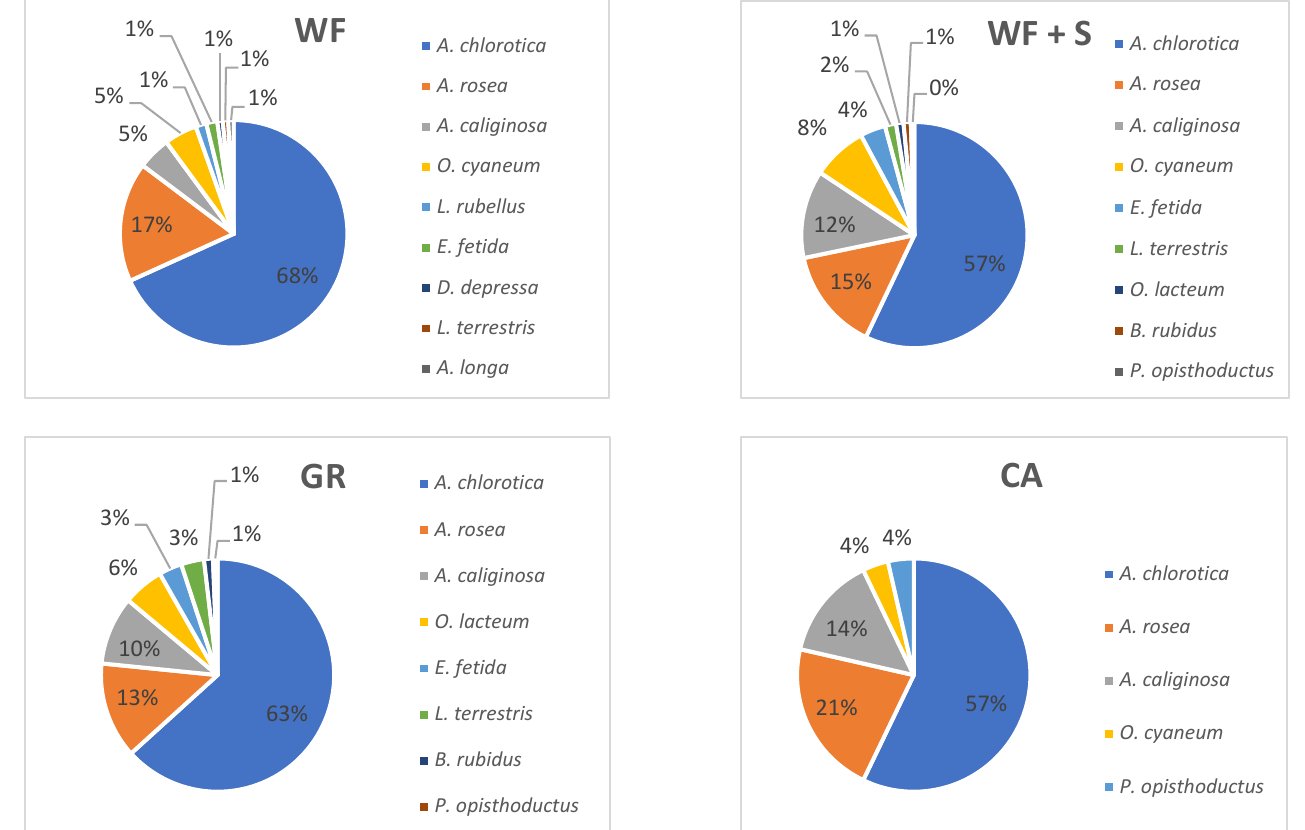
Figure 10. Species compostion of earthworms for the four treatments. (WF: weed control fabric; WF + S: weed control fabric + straw; GR: grass vegetation; CA: cultivated alfalfa; A. chlorotica—Allolobophora chlorotica, A. rosea—Aporrectodea rosea, A. caliginosa—Aporrectodea caliginosa, O. cyaneum—Octolasion cyaneum, L. rubellus—Lumbricus rubellus, E. fetida— Eisenia fetida, D. depressa—Dendrobaena depressa, L. terrestris—Lumbricus terrestris, A. longa—Aporrectodea longa, O. lacteum—Octolasion lacteum, B. rubidus—Bimastos rubidus, P. opisthoductus—Proctodrilus opisthoductus ; Ősagárd, Hungary) .